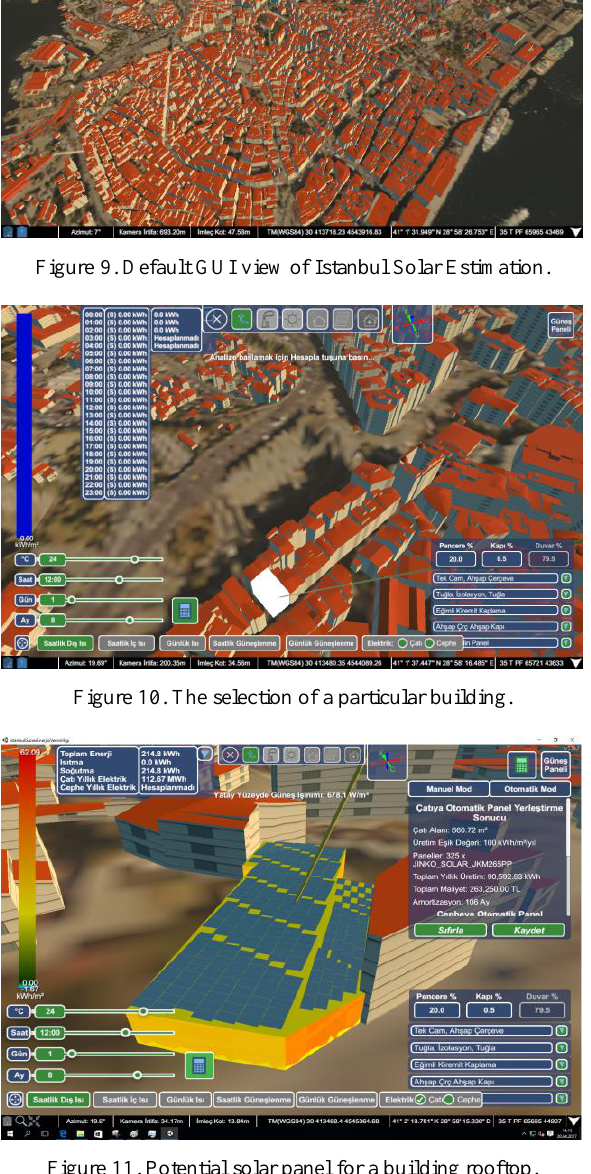
Figure 11. Potential solar panel for a building